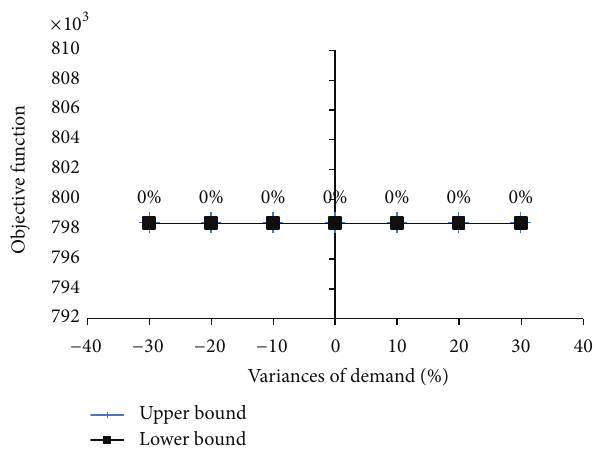
Figure 11: Sensitivity of objective function to changes in fixed installation cost for 49-node data sets.